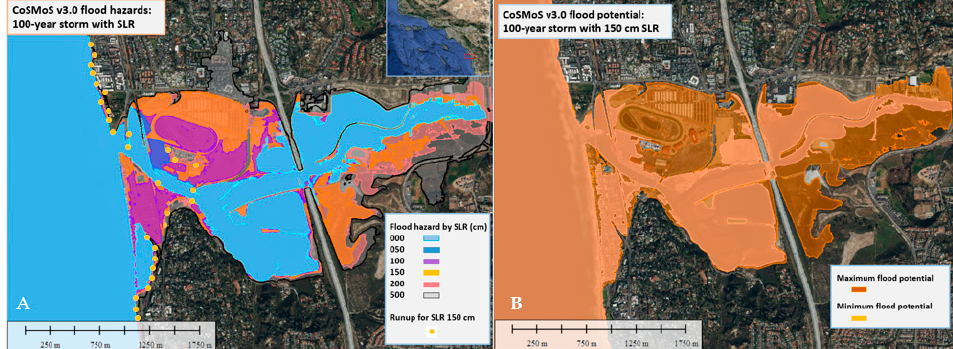
Figure 11. Projected flood hazards for Del Mar, California: ( A ) flood hazard projections for 100-year storm scenario and various SLR. Maximum runup generated along 100-m space transects, representing landward wave-driven potential wetting extent, for SLR 150 cm is shown in orange circles; and ( B ) flood potential for 100-year storm scenario and 150 cm SLR.